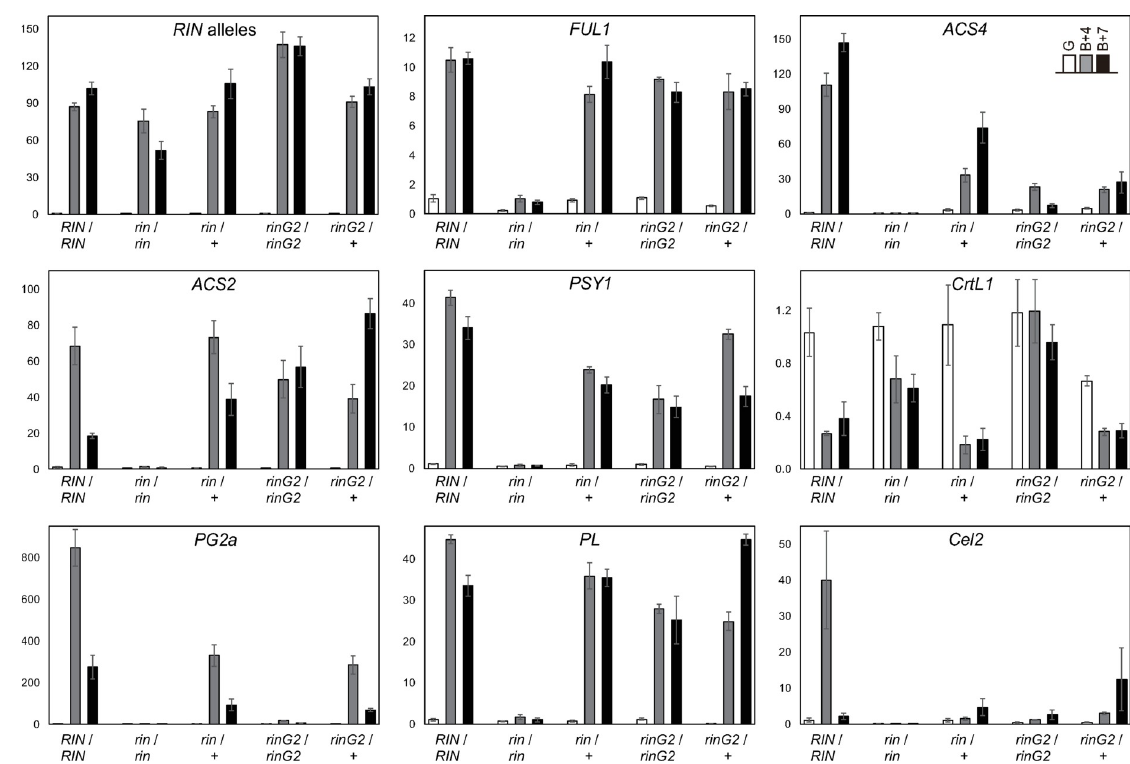
Fig 4. The expression of ripening-associated genes in rinG2/+ fruit. mRNA levels were measured by qRT-PCR. mRNA was prepared from fruits at the green-coloring stage just before the initiation of ripening (G) and fruits during ripening (4 and 7days after the breaker stage; B+4 and B+7). A primer set for the RIN alleles anneals to a common sequence of the wild type, rin , and rinG2 alleles. Data represent the means ± SE of three biological